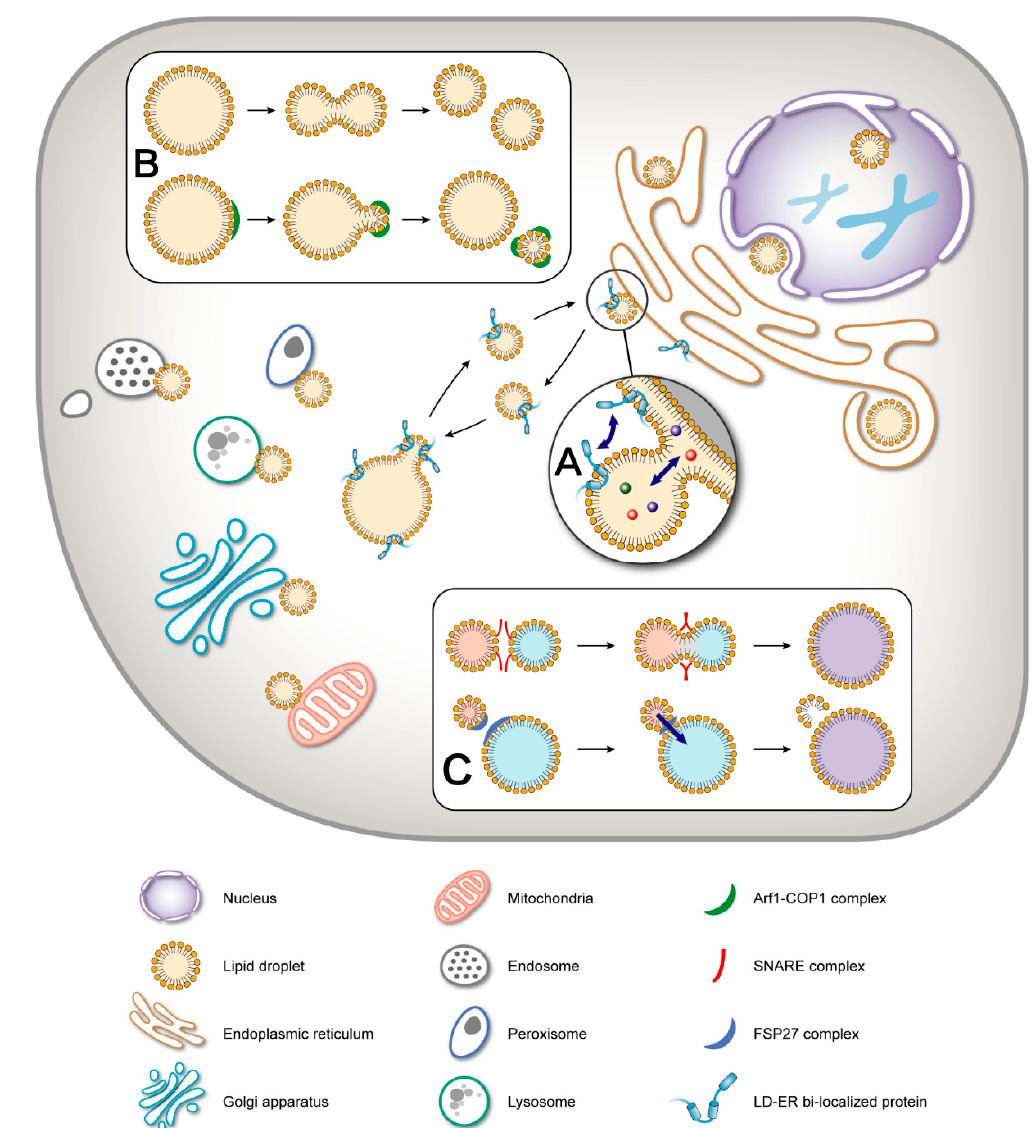
Figure 1. Dynamics of lipid droplets (LDs). As an organelle, a lipid droplet presents a very active status in cells, including movement, interaction with other cellular organelles, and size change. ( A ) LDs can interact with the endoplasmic reticulum (ER) through LD-ER contact sites. The action is to exchange material and information between the two organelles. ( B ) A large LD can be divided into smaller LDs by two means: fission and budding. ( C ) Two small LDs can form a large LD using fusion and neutral lipid transportation.